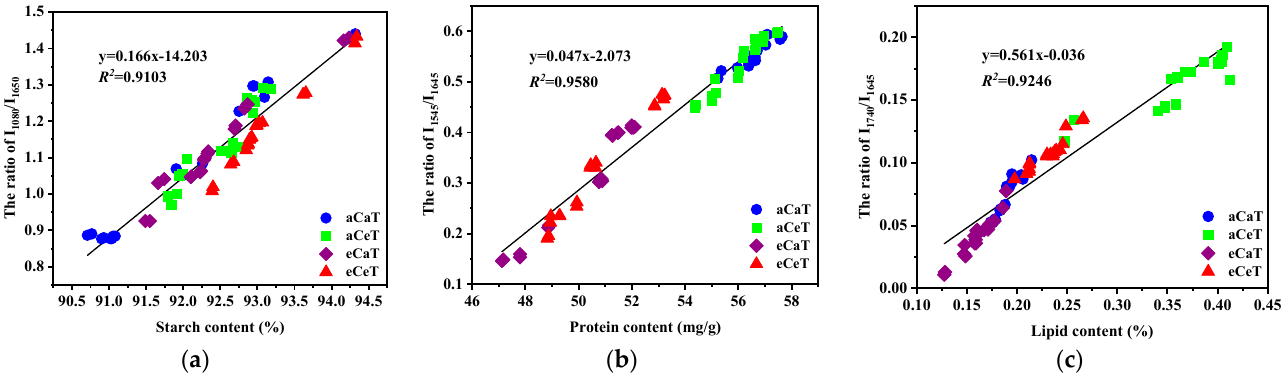
Figure 7. Linear regression between ( a ) starch content and the ratio of I 1080 /I 1650 ; ( b ) protein content and the ratio of I 1545 /I 1650 ; and ( c ) lipid content and the ratio of I 1750 /I 1650 . Note: aCaT, aCeT, eCaT, and eCeT refer to ambient conditions, increased temperature, elevated CO 2 , and the combination of elevated CO 2 and increased temperature, respectively. The linear functions and the square of the correlation coefficient ( R 2 ) are shown in each plot.